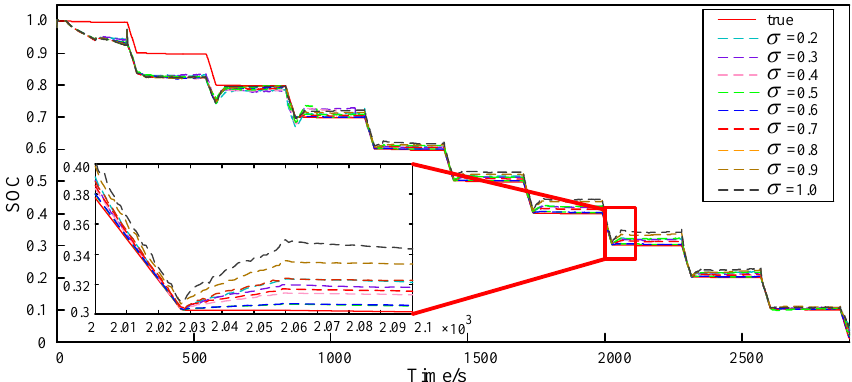
Table 6. Estimation error under different kernel widths.